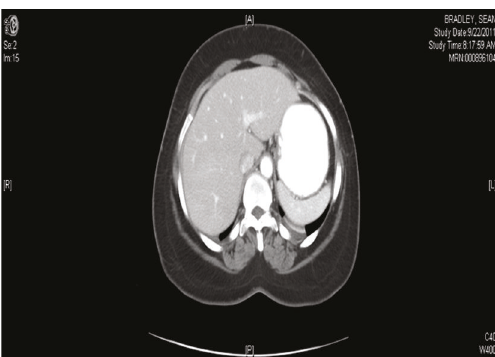
Figure 1: Normal appearing liver capsule and no perihepatic fluid collection.